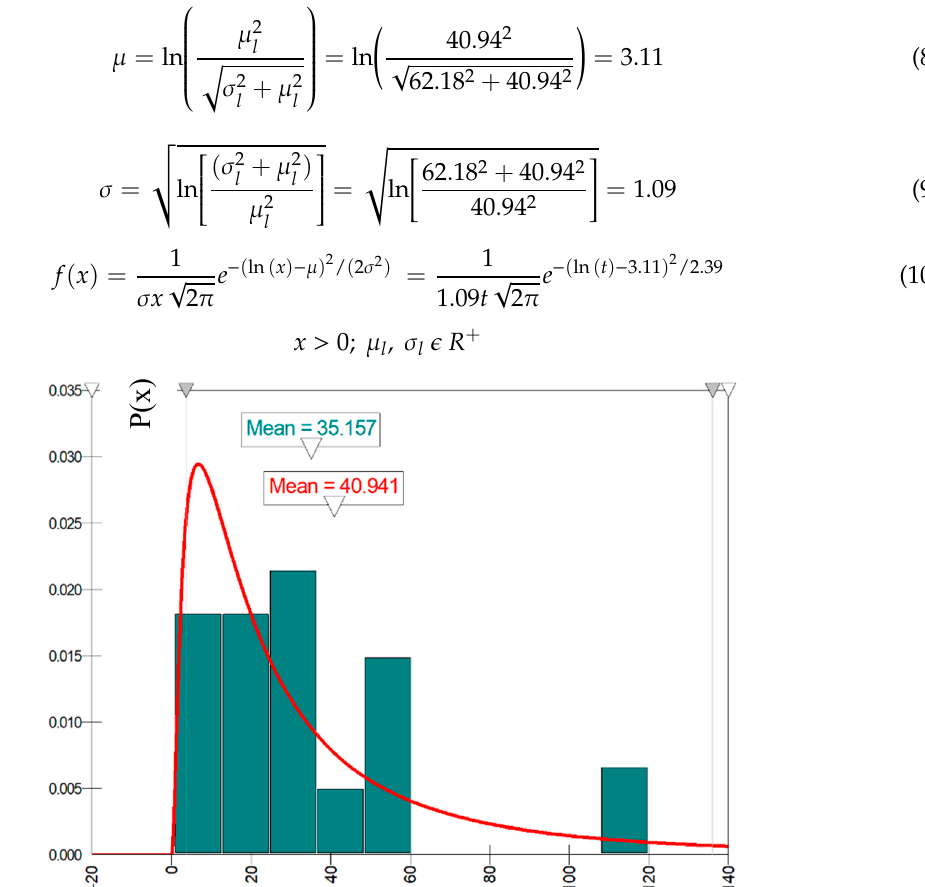
Figure 5. Time between two incoming calls via ship’s internal phone system [min].